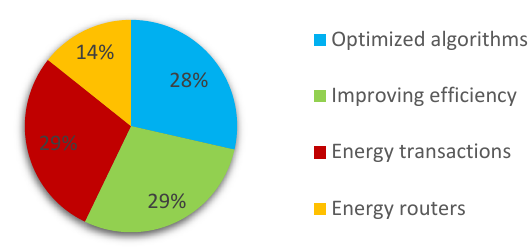
Figure 10. Research situation of blockchain in power transmission and distribution.